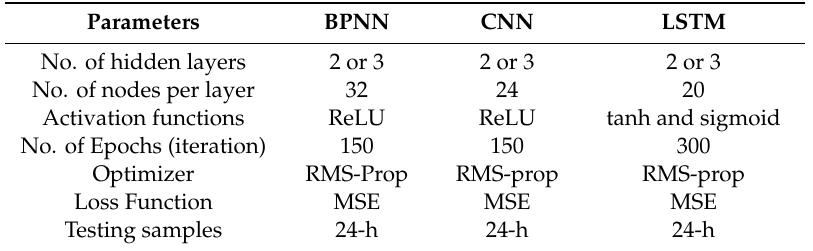
Table 1. Hyper parameters for selected deep learning models.